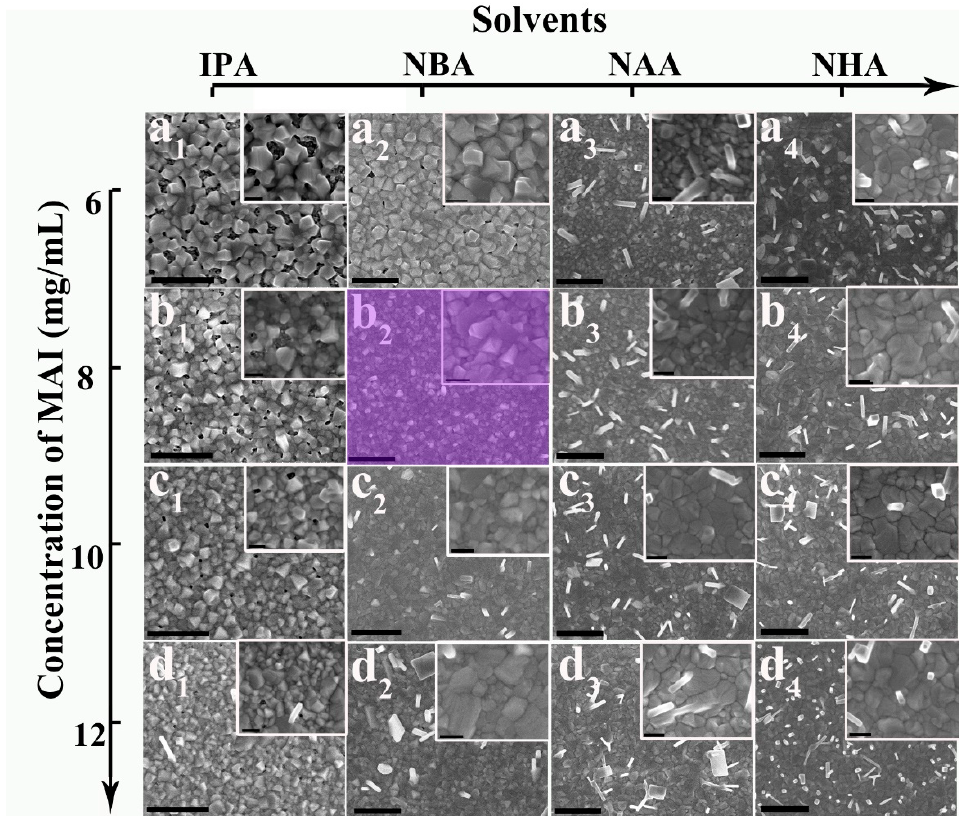
Figure 1. Field emission scanning electron microscope (FE-SEM) images of CH 3 NH 3 PbI 3 (MAPbI 3 ) films obtained from 6–12 mg/mL CH 3 NH 3 I (MAI) in ( a 1 – d 1 ) isopropanol (IPA), ( a 2 – d 2 ) n -butyl alcohol (NBA), ( a 3 – d 3 ) n -amyl alcohol (NAA), and ( a 4 – d 4 ) n -hexyl alcohol (NHA). The scale bars of a 1 – d 4 are 1 μ m, and those of inserts are 200 nm.